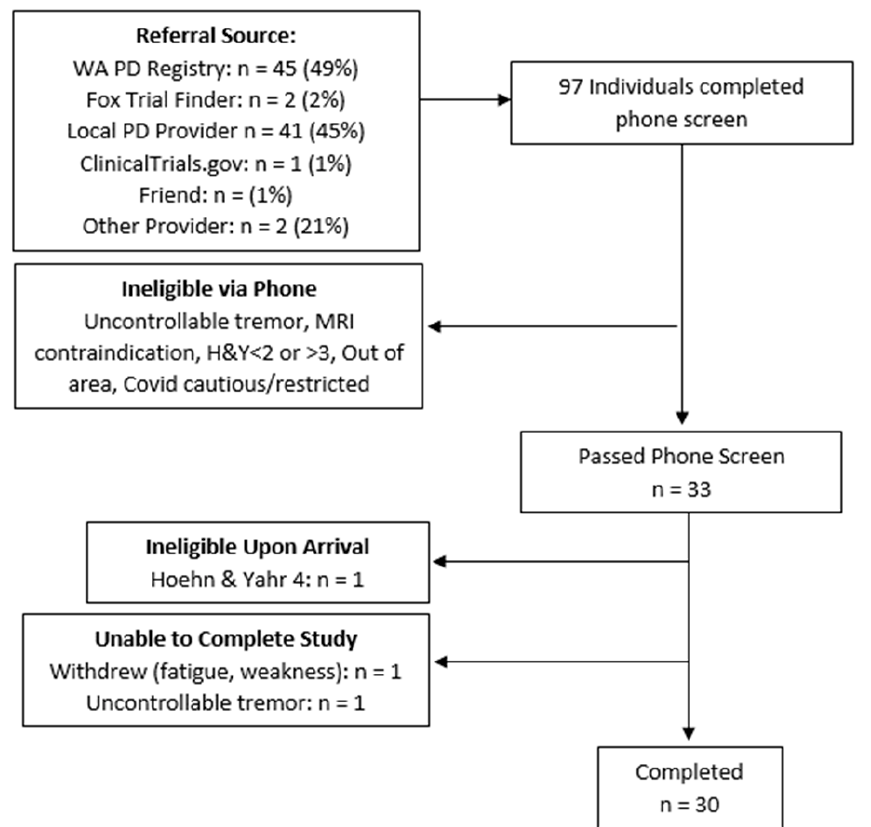
Figure 1. STROBE Flow Diagram of Experimental Model and Subject Details. 97 individuals were screened for inclusion over the phone, 64 of whom were determined to not meet study inclusion criteria. Of the 33 individuals invited to attend the in-person screening, one was disqualified upon arrival and two were unable to complete the study. See Supplemental Table S1 for additional information on inclusion and exclusion criteria. Muscle endurance (i.e., resistance to fatigue) was determined on the right hand and leg skeletal muscles using custom-built exercise apparatus [33,36]. Muscle fatigue resistance FDI) and leg ( tibialis anterior , TA) during repeated isometric contractions until exhaustion.